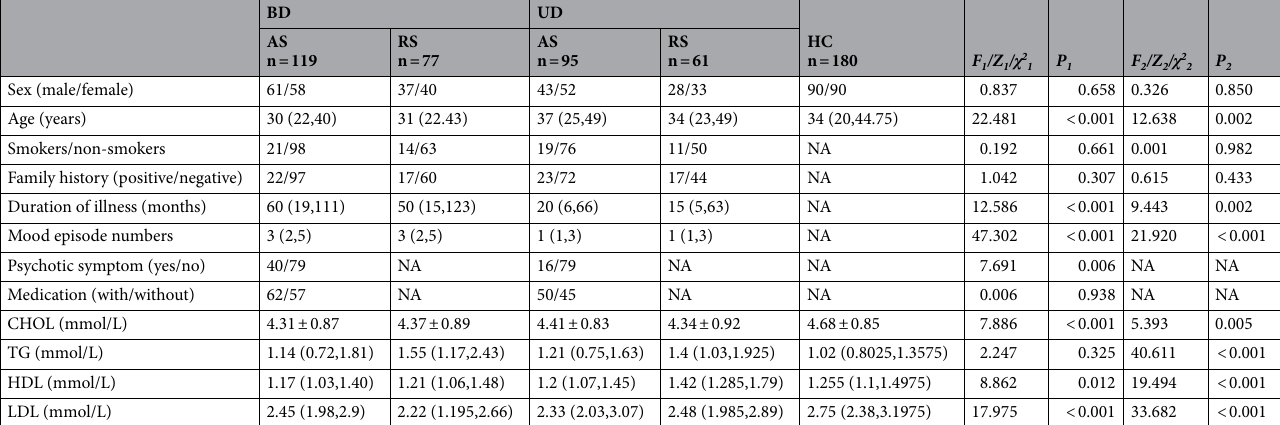
Table 1. Demographic characteristic and clinical data of participants (median (IQR25-75)/mean ± SD). BD, bipolar disorder; UD, unipolar depression; HC, healthy control; AS, acute stag; RS, remission stage. CHOL, total cholesterol; TG, triglyceride; HDL, high-density lipoprotein; LDL, low-density lipoprotein; SD, Standard deviation; IQR, Interquartile range. 1 , comparison among 3 groups in acute stage. 2 , comparison among 3 groups in remission stage.